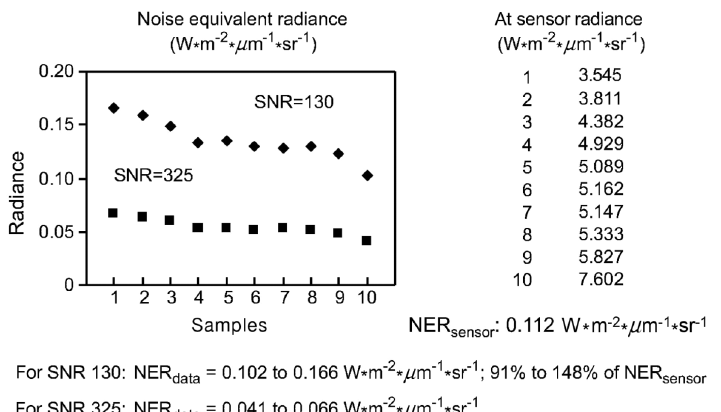
Fig. 8. Radiance equivalent to the noise in the data (NER data ) for two sensor SNRs; the samples are ordered ac- cording to increasing reflectance. Sensor NER (NER sensor ) is the mean, for all sensor channels, of the NER de- termined during the sensor calibration. See the text for explanation.